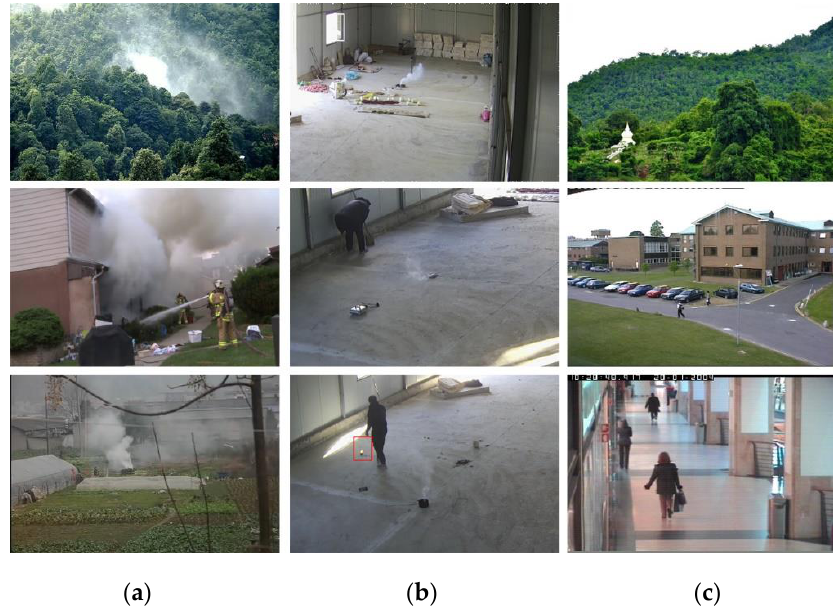
Figure 6. Dataset. ( a ) The smoke images were downloaded from the internet; ( b ) The small and thin images were created in a warehouse; ( c ) The non-smoke images were downloaded from the internet.